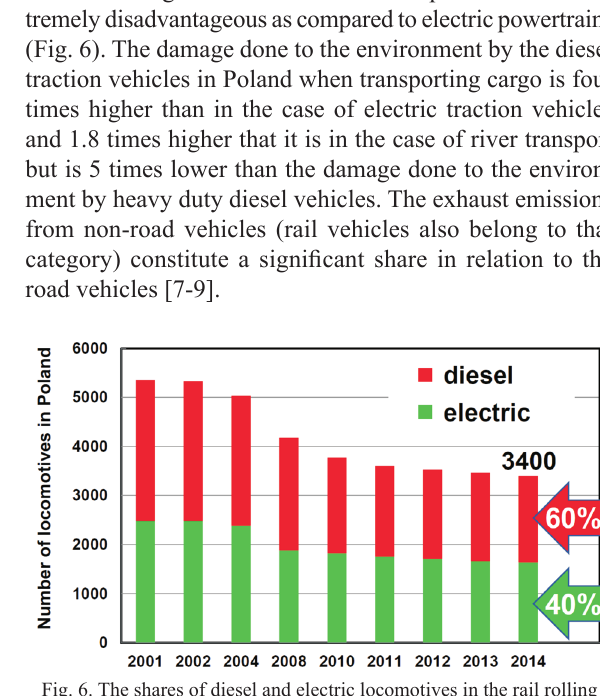
Fig. 6. The shares of diesel and electric locomotives in the rail rolling stock in individual